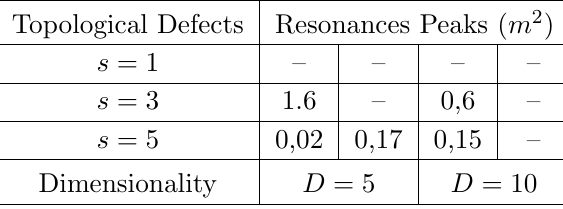
Table 5 . Peaks of resonances for massive right handed